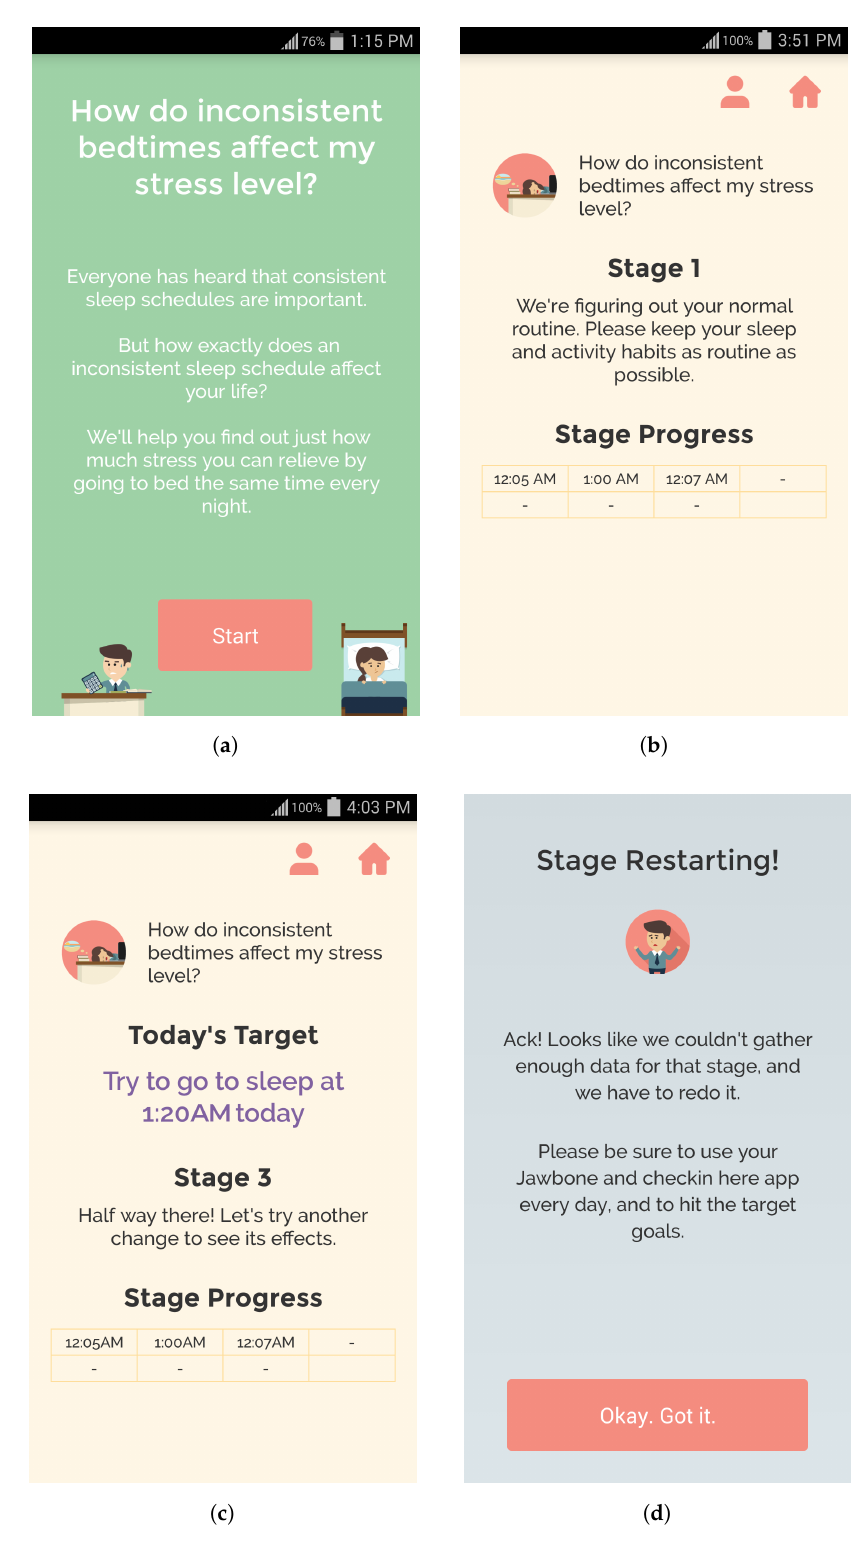
Figure 2. Screenshots of the QuantifyMe Android app: ( a ) information provided before starting an experiment; ( b ) example of instructions during Stage 1 (baseline period); ( c ) example of instructions during Stage 3; and ( d ) example of stage restart